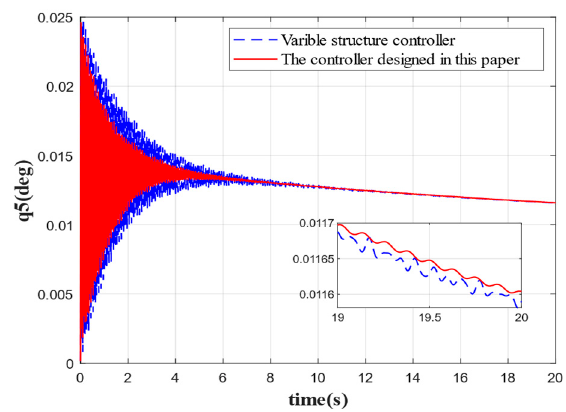
Figure 17. Fifth ‐ order elastic vibration mode with external interference.